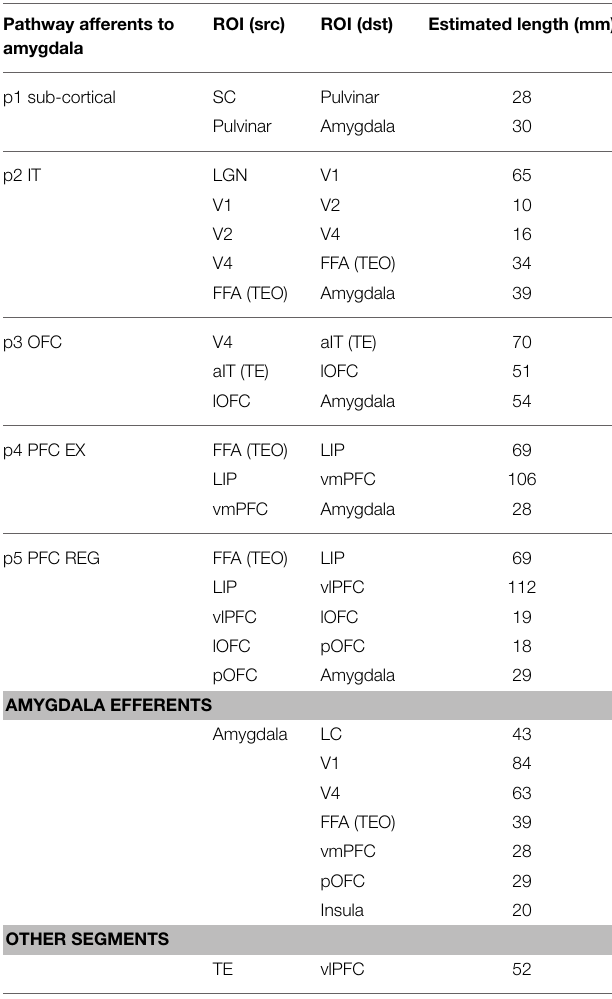
TABLE 4 | Estimated distances along each visual fear signaling pathway edge, between ROI nodes. Pathway afferents to